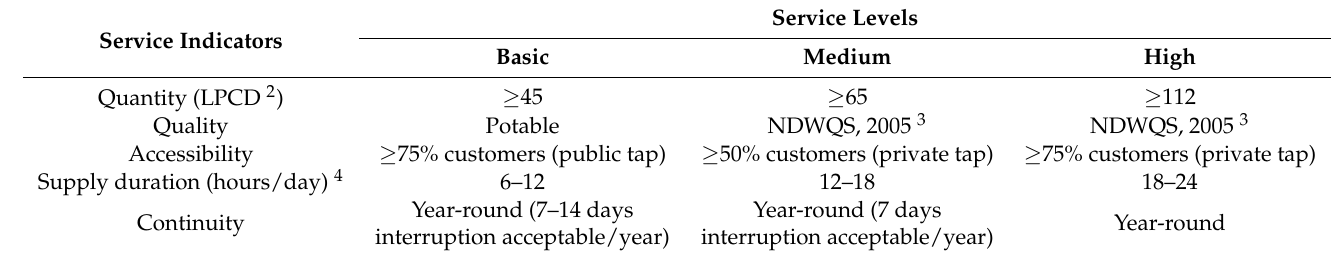
Table 2. Category of water supply services 1